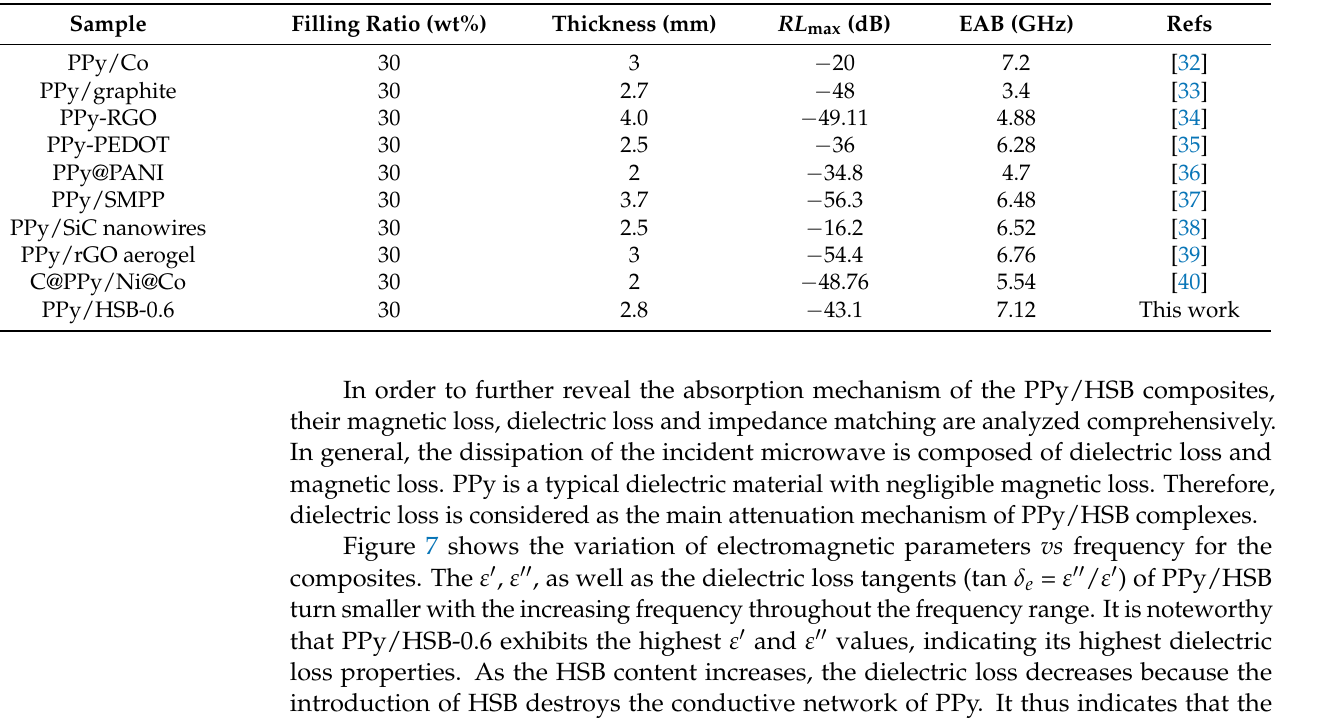
Table 1. Microwave absorption properties of some typical PPy-based materials reported in paraffin matrix.